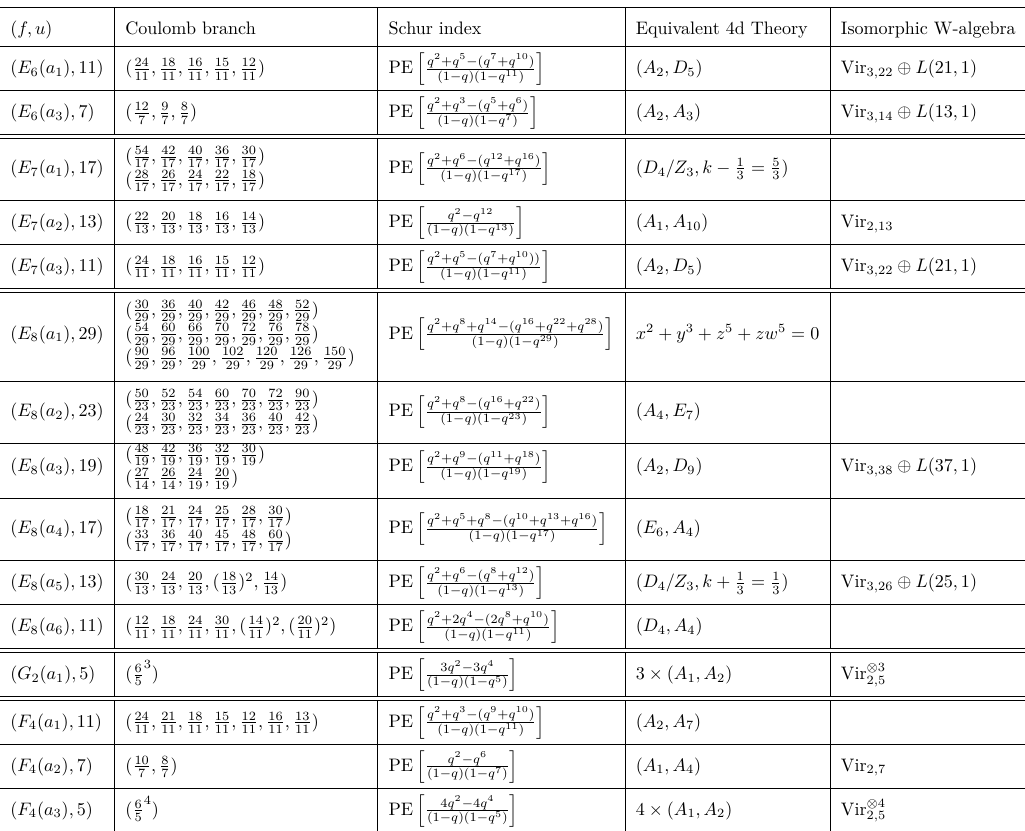
∨ ( g , f ) with u < h ∨ and g is of EFG type. Again f denotes a regular Table 9 . Lisse VOA W − h ∨ + h u singularity with no mass deformation , and u specifies the irregular singularity. The second and the third columns list dimensions of all Coulomb branch operators of T [ W − h ∨ + h ∨ ( g , f )] and its Schur u index (vacuum character) respectively. The fourth column gives another 4d SCFT description of the same theory. The last column gives another VOA (if any) which is isomorphic to W − h ∨ + h ∨ ( g , f ) u which are obtained by matching the central charge, vacuum character and the corresponding 4d theories. W-algebra isomorphisms and other properties for cases with f subregular were studied in [26]. Vir is the vacuum module of Virasoro minimal model with label ( p, q ) , and L ( a, b ) is a p,q module of the previous minimal model with label ( a, b )